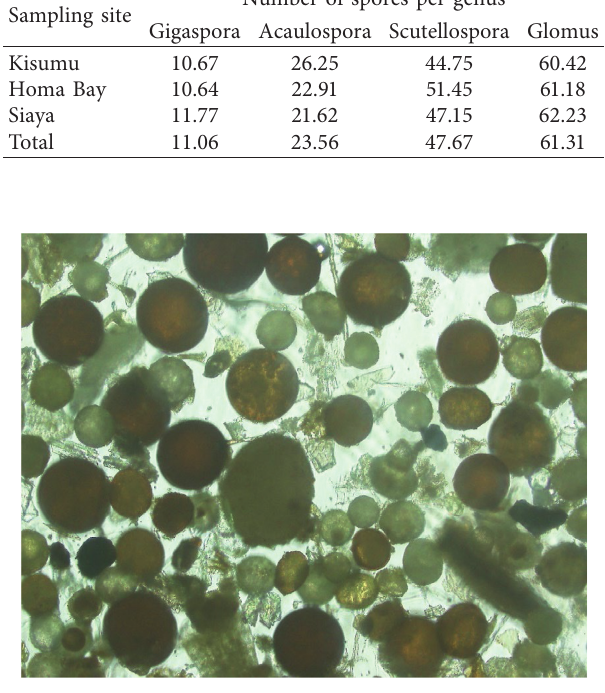
Figure 4: Micrographs of spores observed under × 50 florescent microscope showing different shapes, colours, and subtending